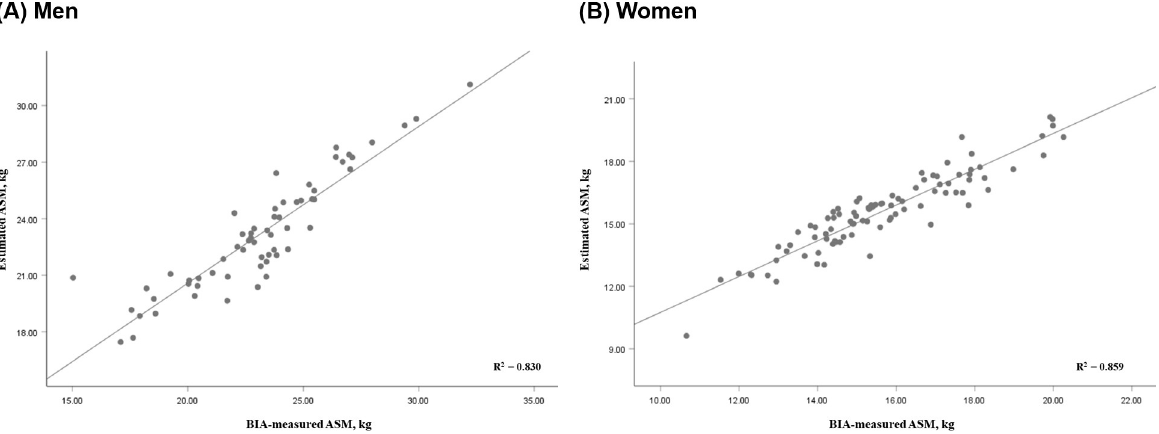
Fig 2. Relationship between the BIA-measured ASM and estimated ASM in the model development group. BIA, bioelectrical impedance analysis; ASM, appendicular skeletal muscle